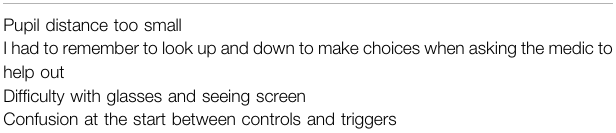
dif fi culties or suggestions. ” ( direct quotes with spelling corrections only ) Pupil distance too small I had to remember to look up and down to make choices when asking the medic